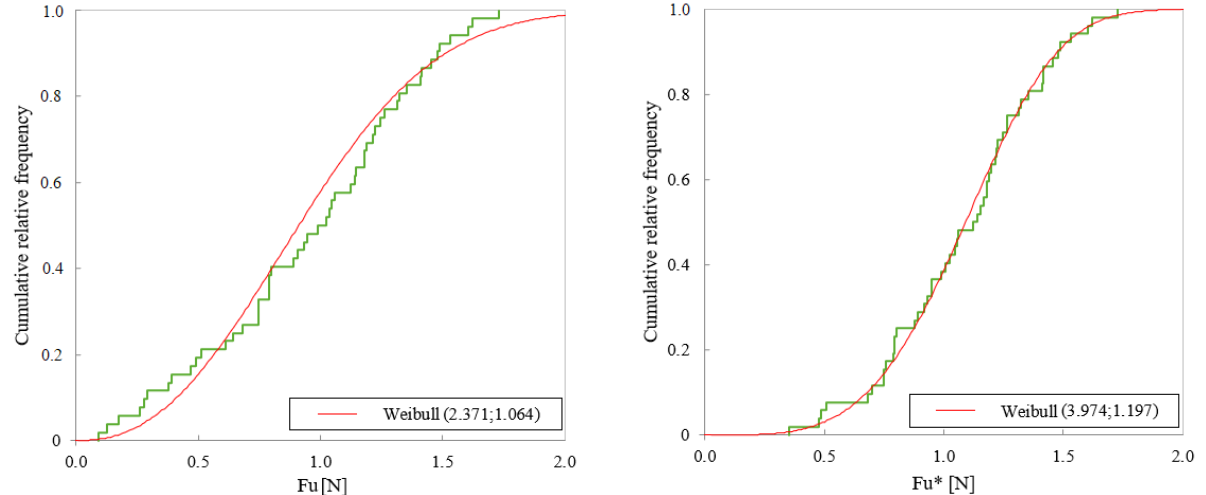
Figure 4. Comparison of the Cumulative Distribution Function (CDF) for the ultimate axial force ( F u ) and the intrinsic ultimate force ( F ∗ u ), red line: Weibull distribution, green line: empirical distribution